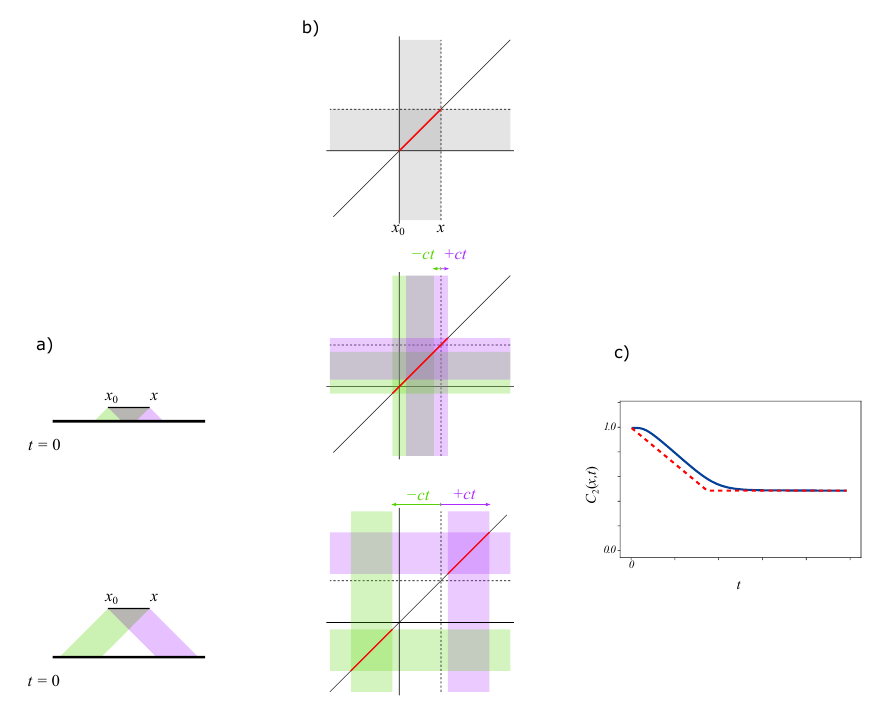
Figure 16: Geometric explanation of the temporal profile of cumulants of the phase difference field ∆ ˆ ϕ = ˆ ϕ ( x , t ) − ˆ ϕ ( x , t ) . (a) Seen from a space-time perspective, 0 the splitting of ∆ ˆ ϕ into two components (left and right moving) can be depicted | / 2 c the two projections on by two stripes of different color. For times t < | x − x 0 | / 2 c they do not. the t = 0 line still overlap with each other, while for t > | x − x 0 ( x , t ) = (cid:10) ∆ ˆ ϕ ( x , t ) 2 (cid:11) (b) To compute the 2nd order cumulant of C we integrate 2 con 〈 ˆ u ( y , t ) ˆ u ( y , t ) 〉 over the variables y and y in the overlapping region of the 1 2 1 2 con corresponding stripes which are shifted from the original interval [ x , x ] by ± ct 0